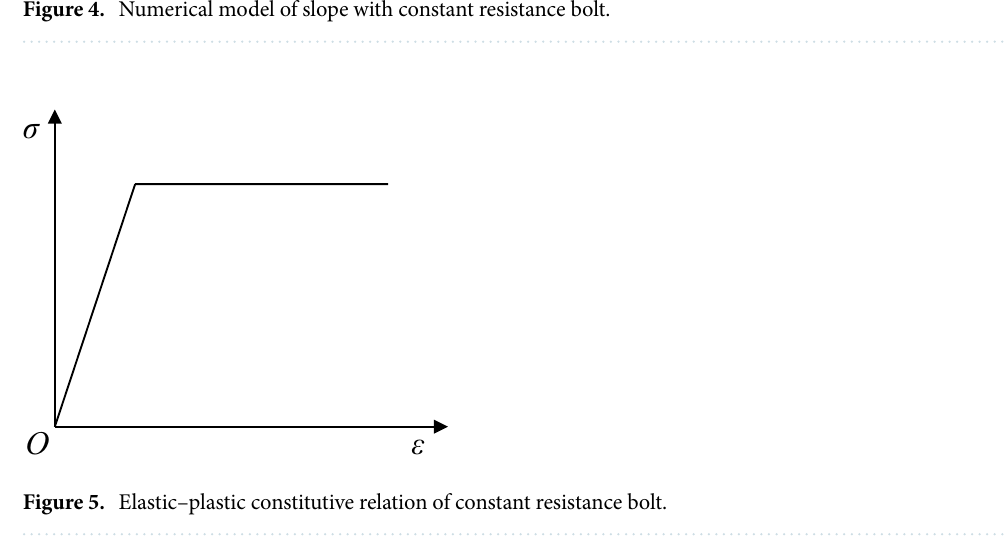
Figure 4. Numerical model of slope with constant resistance bolt.